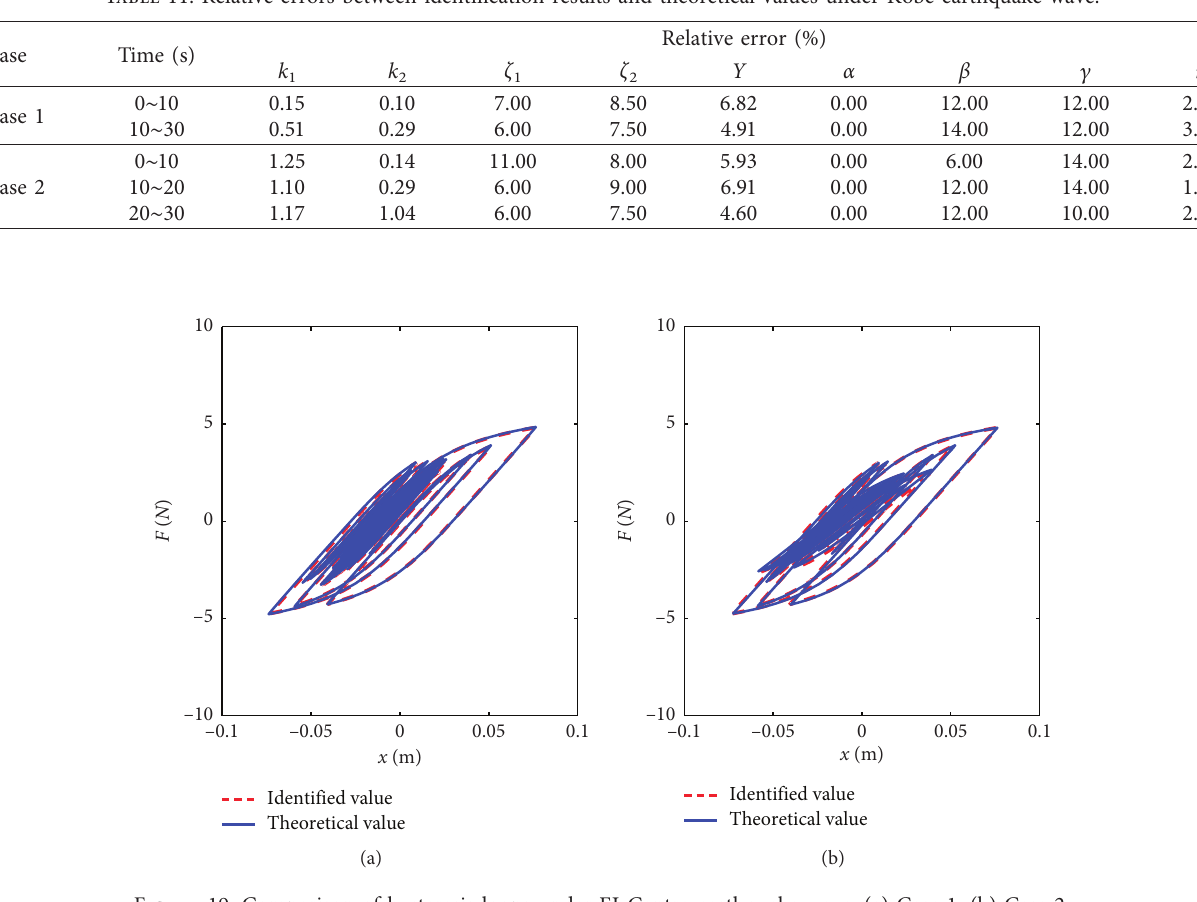
Table 11: Relative errors between identification results and theoretical values under Kobe earthquake